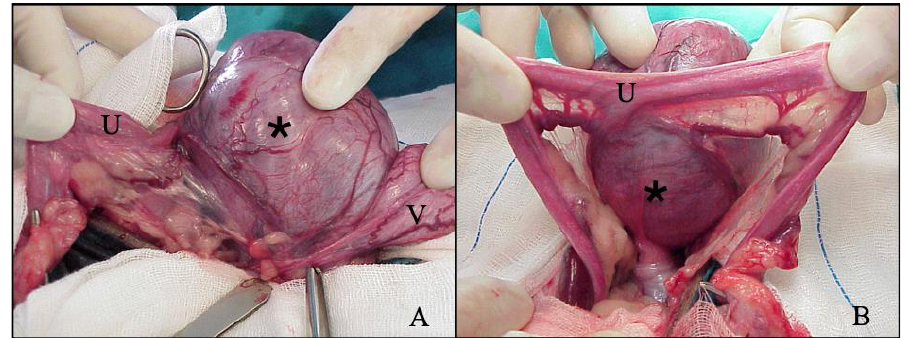
Figure 2. Intraoperative image of neoformation in cranial vagina removed by partial vaginectomy.